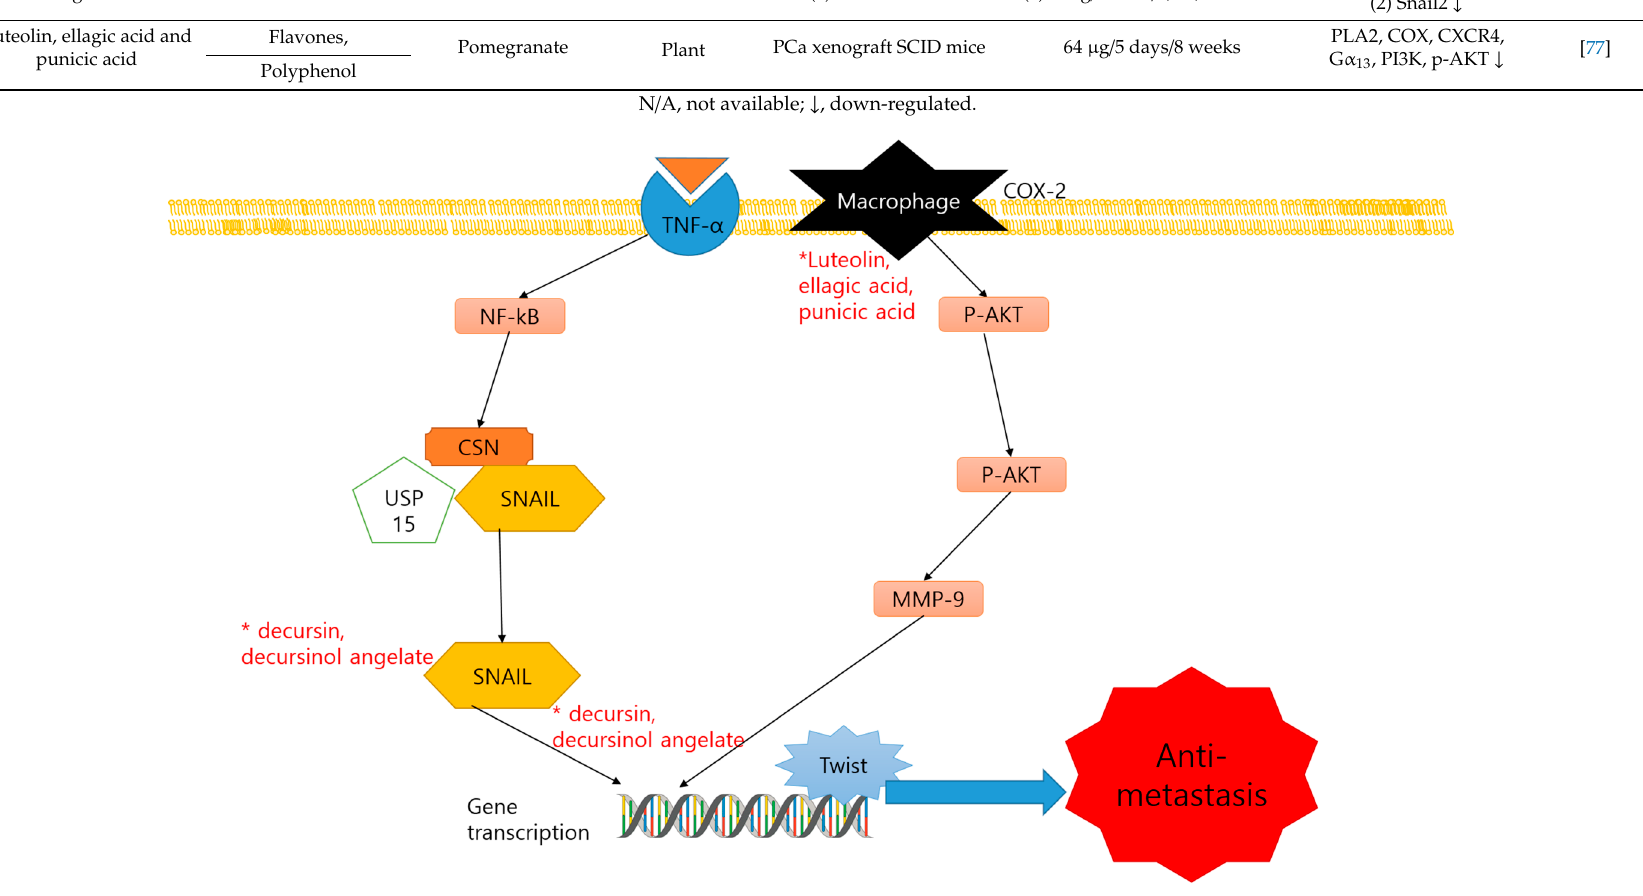
Figure 3. Schematic diagram of anti-metastatic mechanisms of dietary compounds. *, The molecule is regulated by the compounds. Table 6. Anti-metastasis inducing dietary compounds.